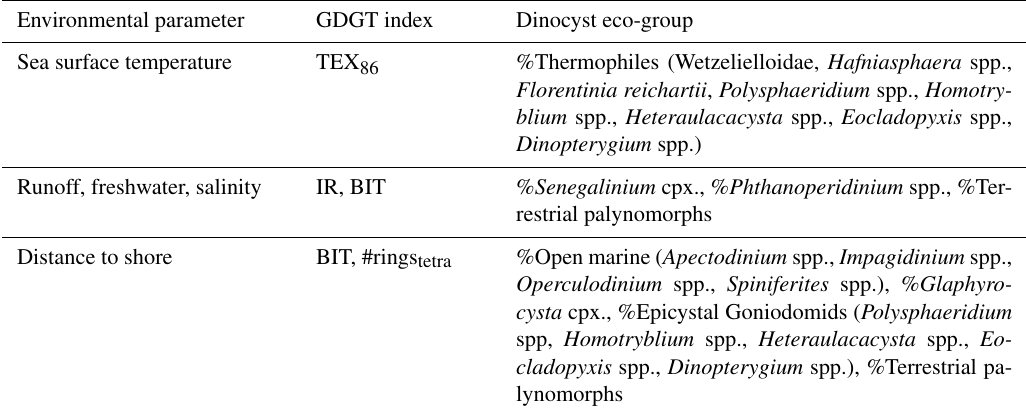
Table 3. Environmental parameters, and their corresponding GDGT indices and dinocyst eco-groups, based on Sluijs et al. (2005), Frieling and Sluijs (2018) and Sluijs and Brinkhuis (2009).